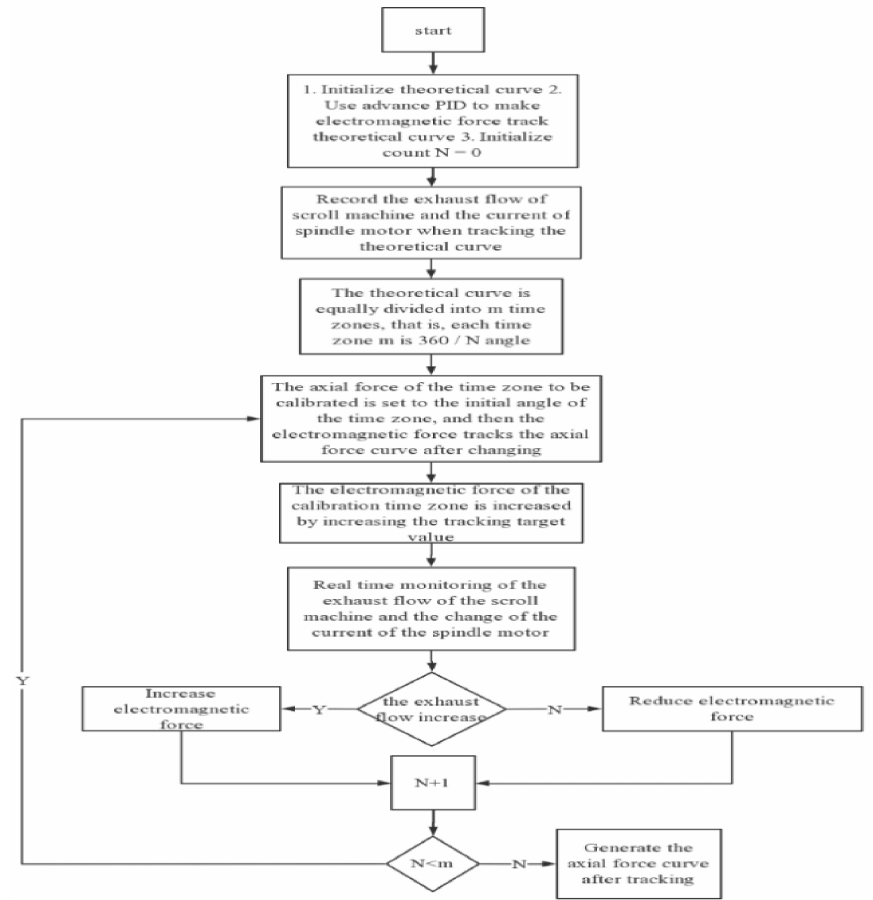
Figure 7. Segmented tracking control flow